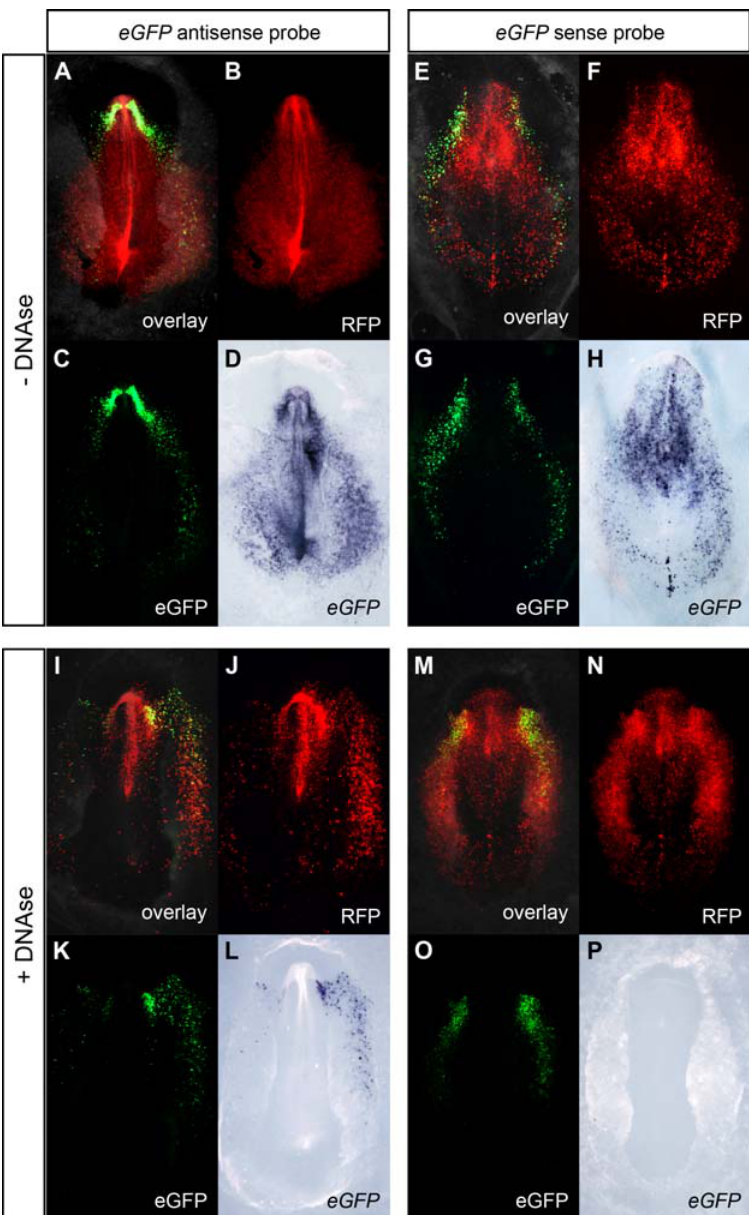
Figure 2. Comparison between eGFP fluorescence and eGFP expression patterns in Cer0.4-eGFP/CAGGS-RFP electroporated chick embryos. Chick embryos were co-electroporated with Cer0.4-eGFP (tissue-specific reporter) and pCAGGS-RFP (ubiquitous reporter) at stage HH3 and processed for WISH. (A, E, I, M) Merge of bright field with fluorescence images. (B, F, J, N) RFP fluorescence. (C, G, K, O) eGFP fluorescence. (D, H, L, P) WISH using eGFP antisense and sense probes. At stages HH6-7, RFP fluorescence was detected in all electroporated cells, whereas eGFP fluorescence was specifically observed in the anterior mesendoderm. When embryos were processed by the standard WISH method, the eGFP antisense probe was detected in both eGFP- and RFP-positive cells (D). These cells were also labeled by the eGFP sense probe (H). In embryos treated with DNase I, the antisense probe was restricted to the eGFP -expressing cell population (L), whereas the sense probe was no longer detected (P).